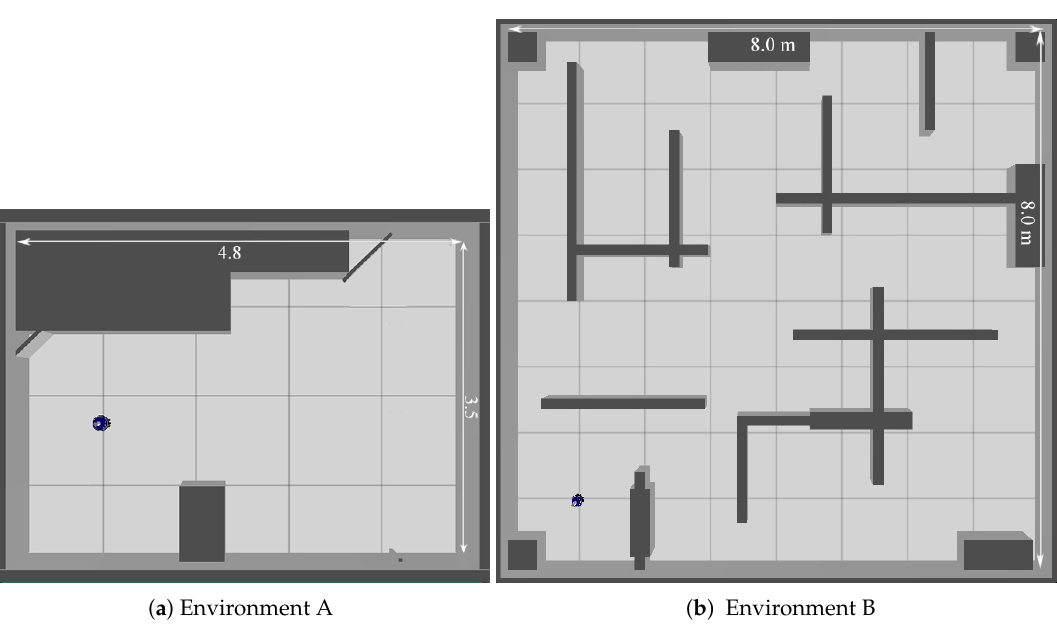
Figure 7. A top view of the environments (A, B) used in the simulation.